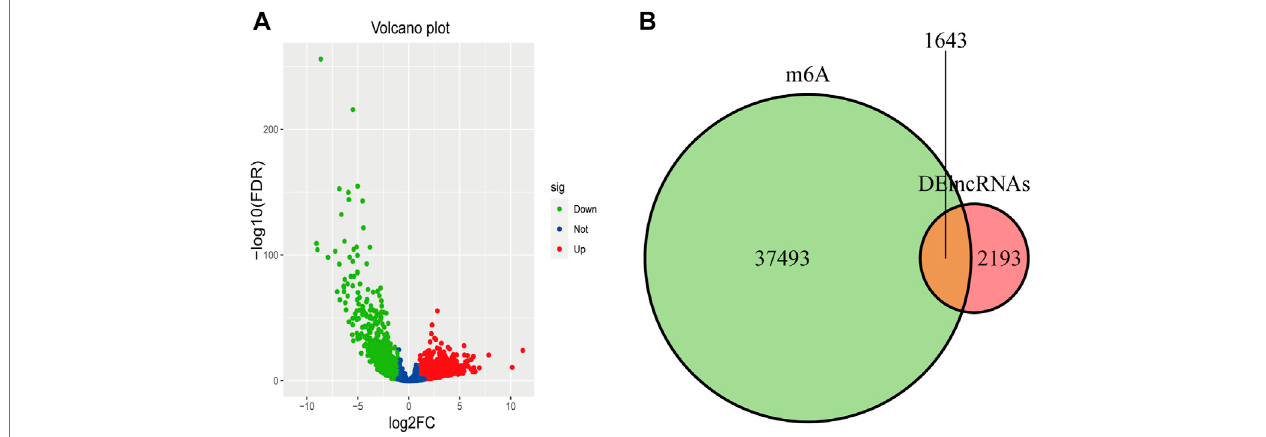
FIGURE 1 | Differentially expressed m6A-lncRNAs. (A) The volcano plot has shown the differentially expressed lncRNAs in the training cohort in KIRC. The green dots,bluedots,andreddotsmeanthedownregulated,nodifferentiallyexpressed,andupregulatedlncRNAs,respectively. (B) TheintersectionofDElncRNAswithm6A- modi fi ed genes was illustrated by the Venn